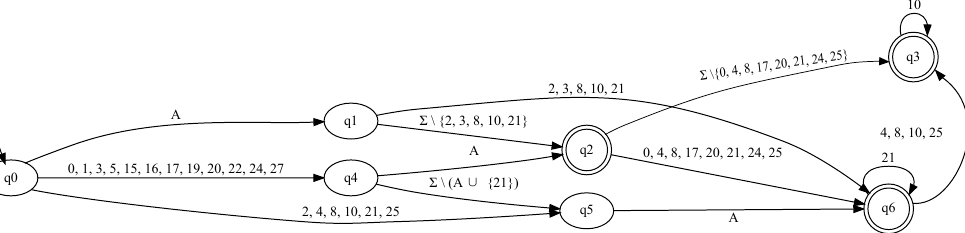
Figure 11. Hadoop file system logs: Automaton for Ψ 1 ( C ) obtained with (cid:101) = 0.01 and δ = 0.01.